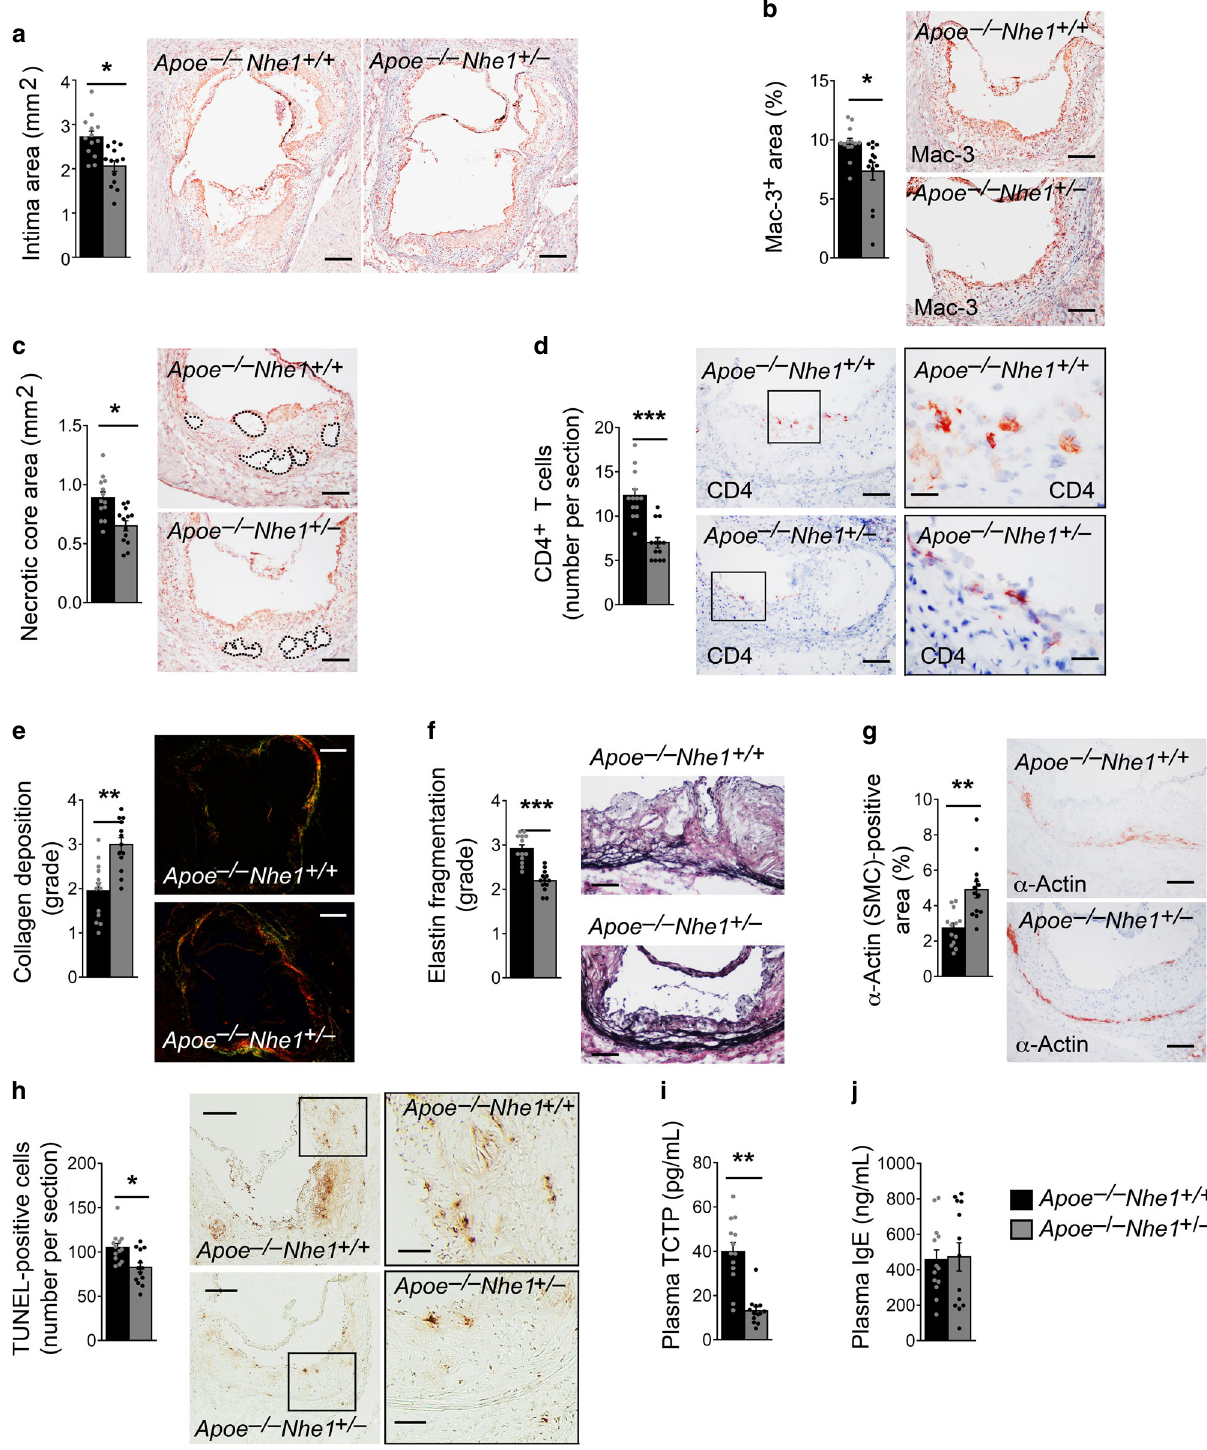
Fig. 2 NHE1-de fi ciency reduces atherogenesis. Aortic roots from Apoe – / – Nhe1 + / – mice have smaller intima area ( a , bars: 500 µ m), reduced lesion Mac-3- positive macrophage accumulation ( b , bars: 200 µ m), smaller necrotic core area ( c , bars: 200 µ m), fewer CD4 + T cells ( d , bars: 200 µ m, inset bars: 50 µ m), increased collagen deposition ( e , bars: 500 µ m, Sirius red staining), reduced elastin fragmentation ( f , bars: 200 µ m, Verhoeff Van Gieson staining), increased lesion SMC contents ( g , bars: 200 µ m), reduced lesion TUNEL-positive apoptotic cell contents ( h , bars: 500 µ m, inset bars: 200 µ m), and reduced plasma TCTP levels i , compared with those from the Apoe – / – Nhe1 + / + control mice. j Plasma IgE levels between the groups. Representative fi gures for panels a – h are shown to the right. Data are mean ± SEM. n = 13 per group. Two-tailed Student ’ s t- test ( a , c , e , f , g , h ) and Mann – Whitney U- test ( b , d , i , j ) were used for statistic analyses. * P < 0.05; ** P < 0.01; *** P < 0.001. Source data are provided as a Source Data fi